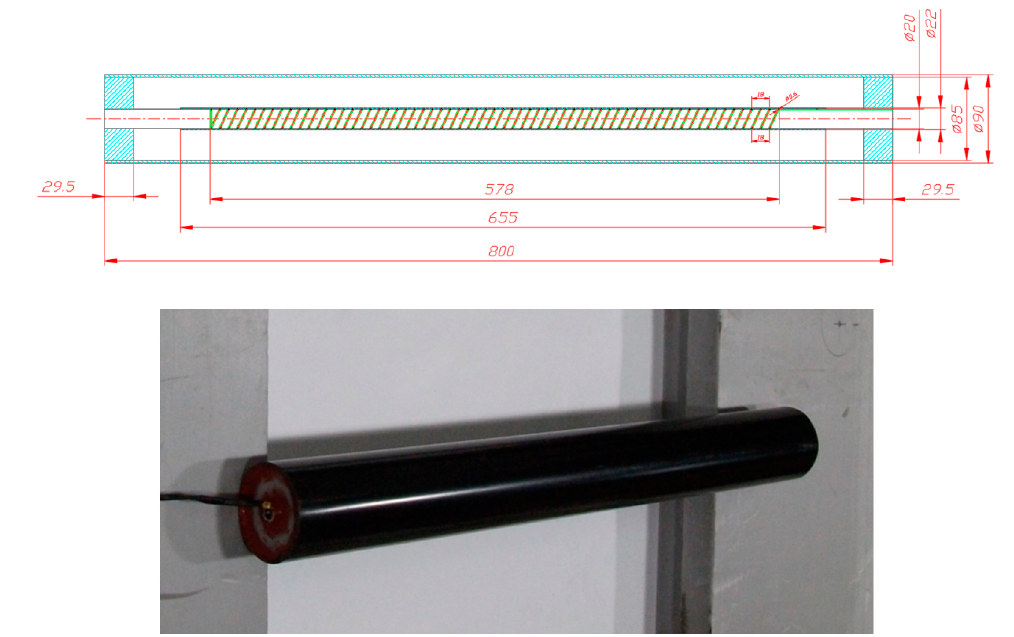
Figure 3. A view of the electric heater.